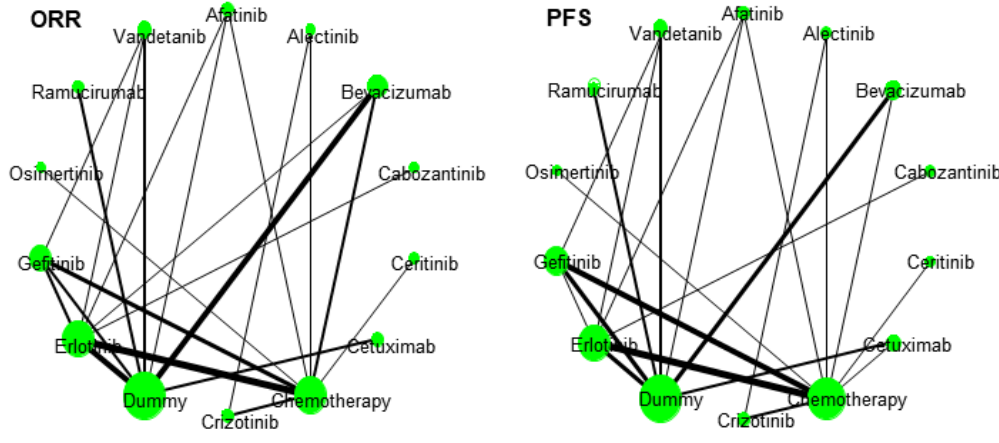
Figure 1. Network geometry of comparisons for overall response rate (ORR) and progression-free survival (PFS).